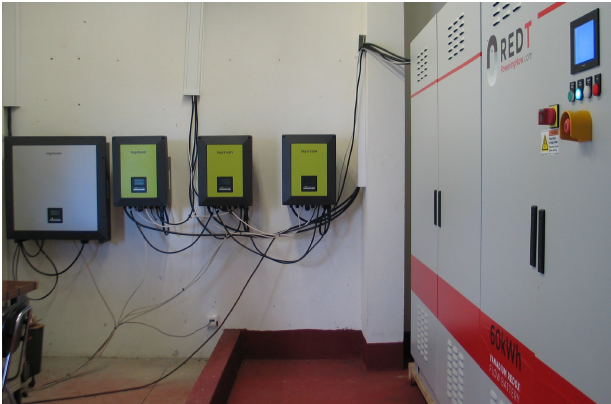
Figure 3. VRFB (right) and the inverters (left).